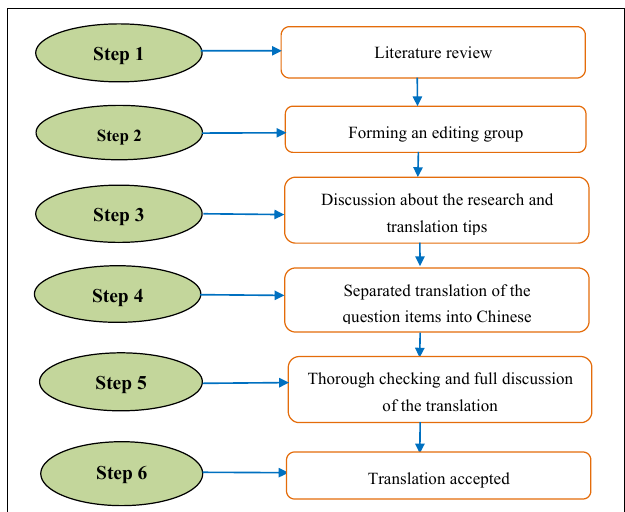
FIGURE 2 | Questionnaire designing